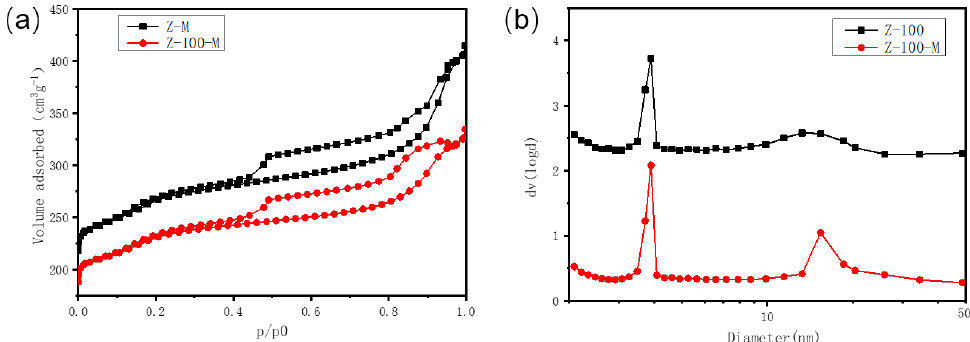
Figure 8. The BET analysis of the Z–100 and Z–100–M catalysts. The ( a ) N 2 sorption isotherms and ( b ) pore size distributions. Table 3. The physical properties of di ff erent catalysts.